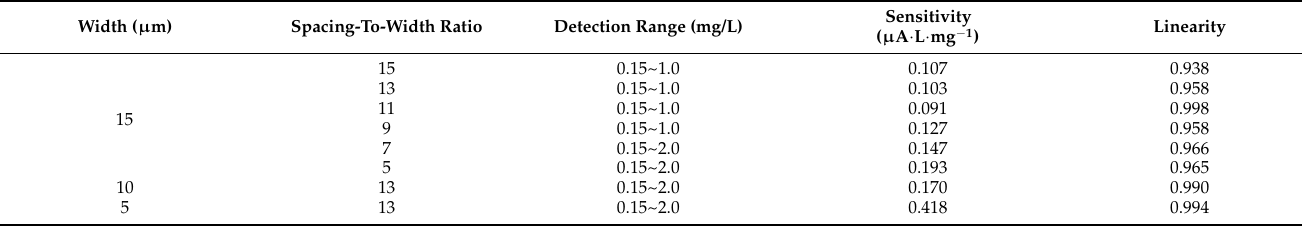
Table 1. Results of NH 3 -N detection using UIAE with various spacing-to-width ratios and widths. Width ( µ m) Spacing-To-Width Ratio Detection Range